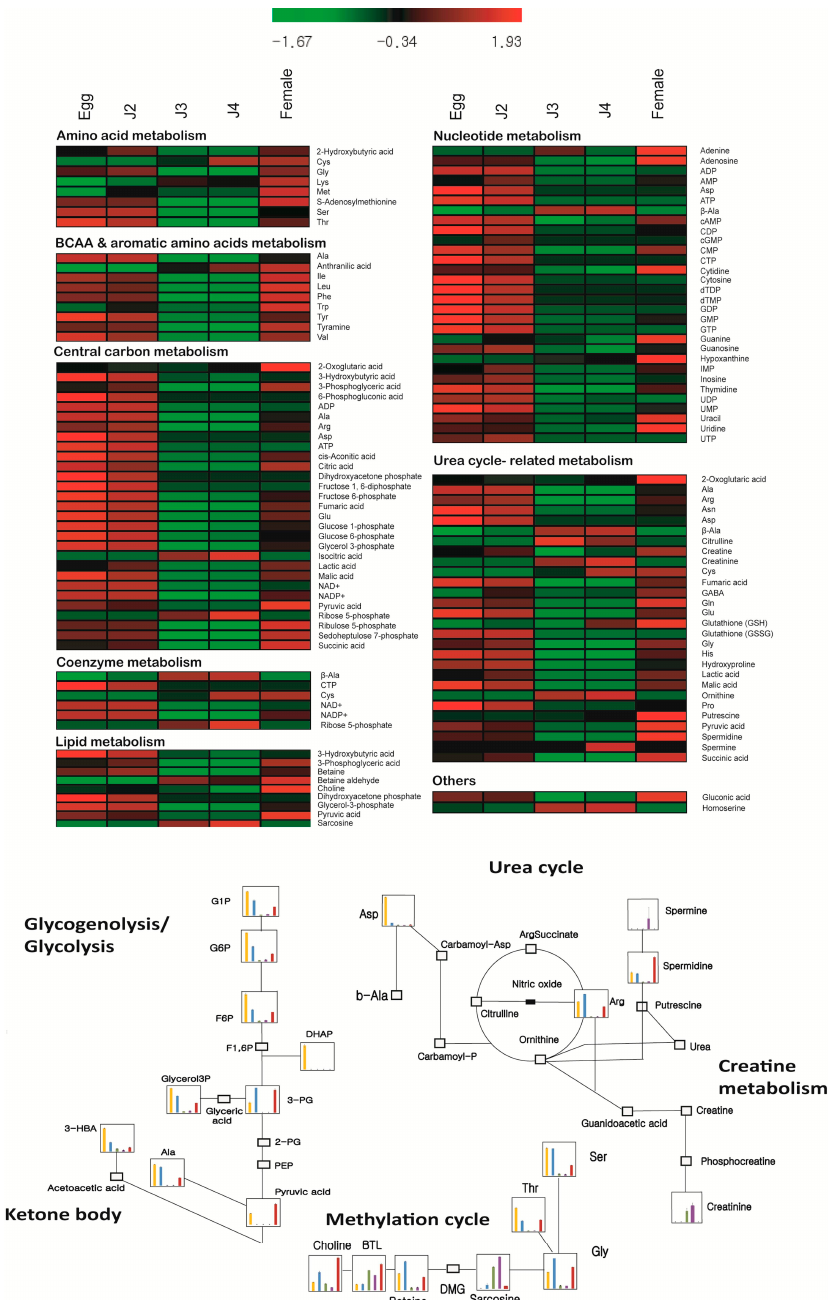
Figure 2. Heat map comparing the levels of 93 metabolites detected in Meloidogyne incognita at various stages of its life cycle. For construction of a comparative heatmap absolute quantified values were normalized and relative expression represented at a range of − 1.67 to 1.93 was used. The metabolites were grouped based on their metabolism into amino acid metabolism, BCAA and aromatic amino acid metabolism, central carbon metabolism, coenzyme metabolism, lipid metabolism, nucleotide metabolism, urea cycle-related metabolism and others. Generation of the heatmap was carried out using MeV (v4.9.0) software [22]. Below: Pathway maps indicating the expression of its constituent metabolites. G1P, glucose 1 phosphate; G6P, glucose 6 phosphate; F6P, fructose 6 phosphate; F1,6P, fructose 1,6 phosphate; DHAP, dihydroxyacetone phosphate; 3-PG, 3-phosphoglycerate; G3P, glyceraldehyde 3 phosphate; 2-PG, 2-phosphoglycerate; PEP, phosphoenol pyruvate; 3-HBA, 3-hydroxybutyrate; b-Ala, beta alanine; BTL, betaine aldehyde; DMG, N,N- Dimethylglycine.